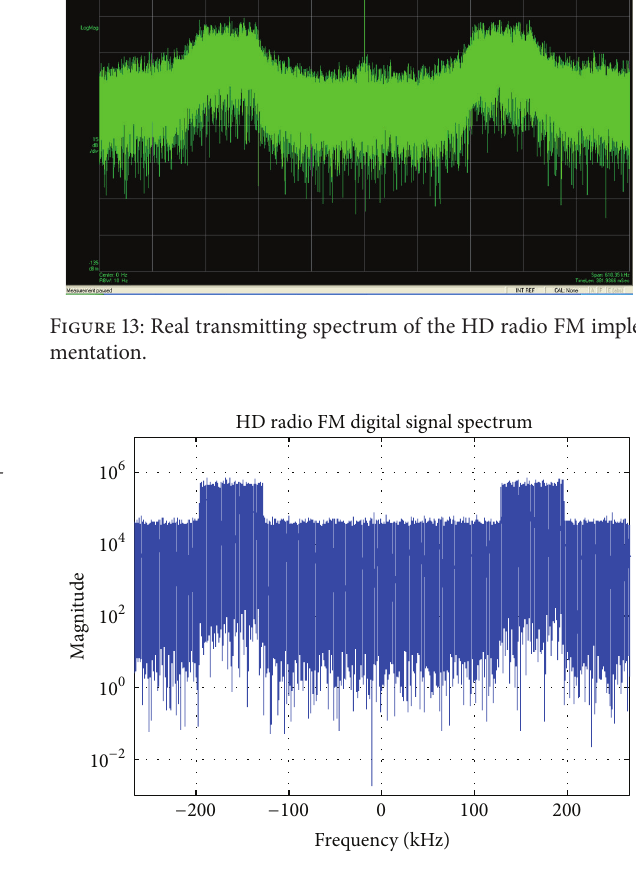
Figure 14: Simulated transmitting spectrum of the HD radio FM